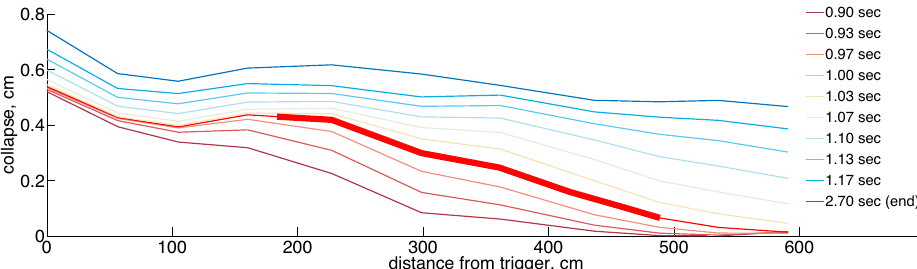
Figure 6. Wavelength of a PST. Collapse values shown during failure. The final value at 2.7s is the total collapse after the beam stopped moving. The thick red line shows an estimate of the section of the beam undergoing rapid collapse (phase ii in Sect. 2.3), from which wavelength was estimated. The wavelength is ∼ 3m. Test 9